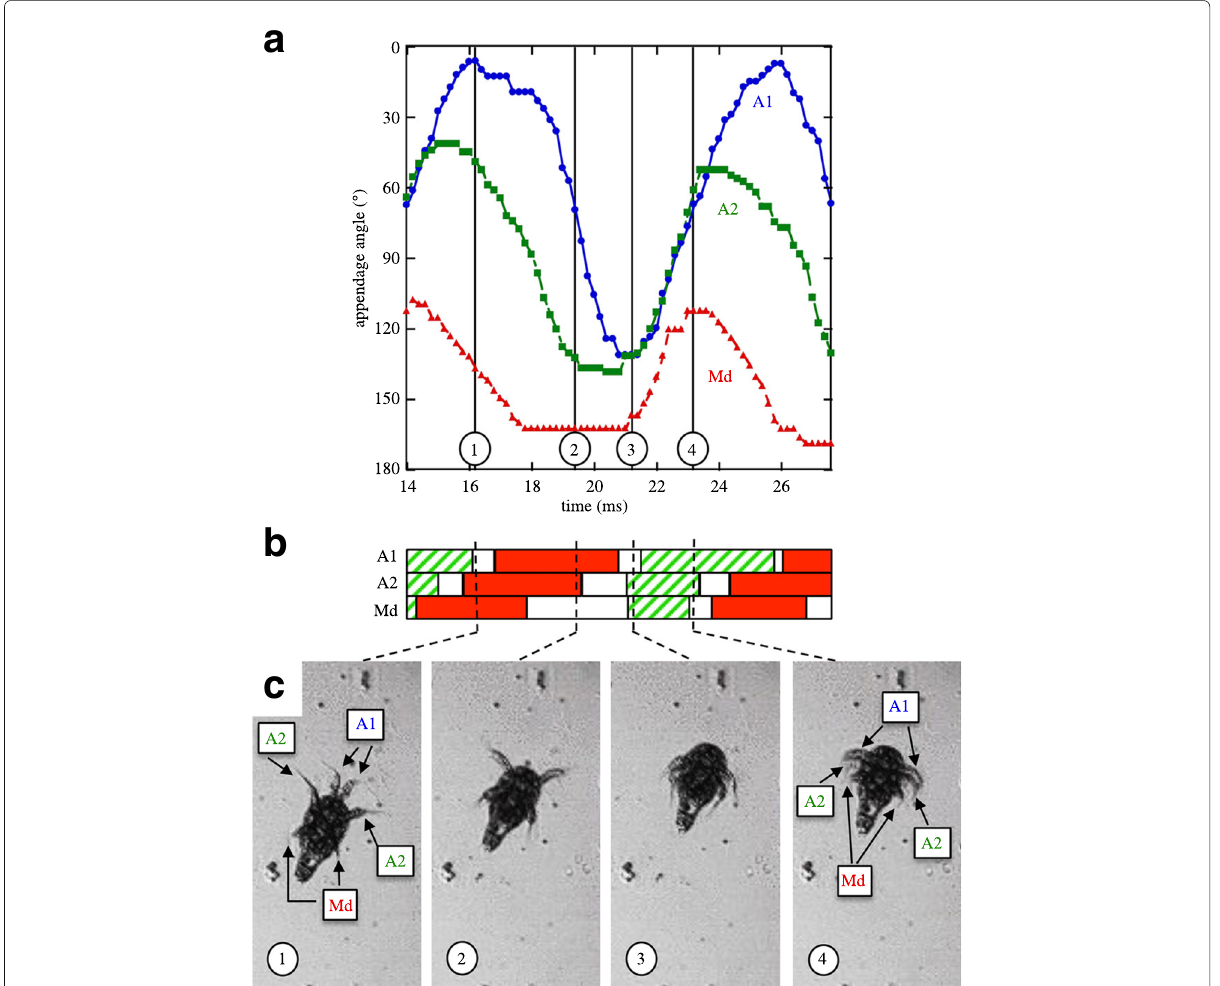
Fig. 22 Measured movements of a larval copepod. Panel ( a ) shows variations over time of the orientation angles of three leg pairs, labeled as A1, A2, Md. Panel ( b ) shows time intervals when each leg pair performs a power stroke (red), a return stroke (green stripes), or remains stationary (white). Panel ( c ) shows snapshots of the copepod at four representative times. Figure reproduced from